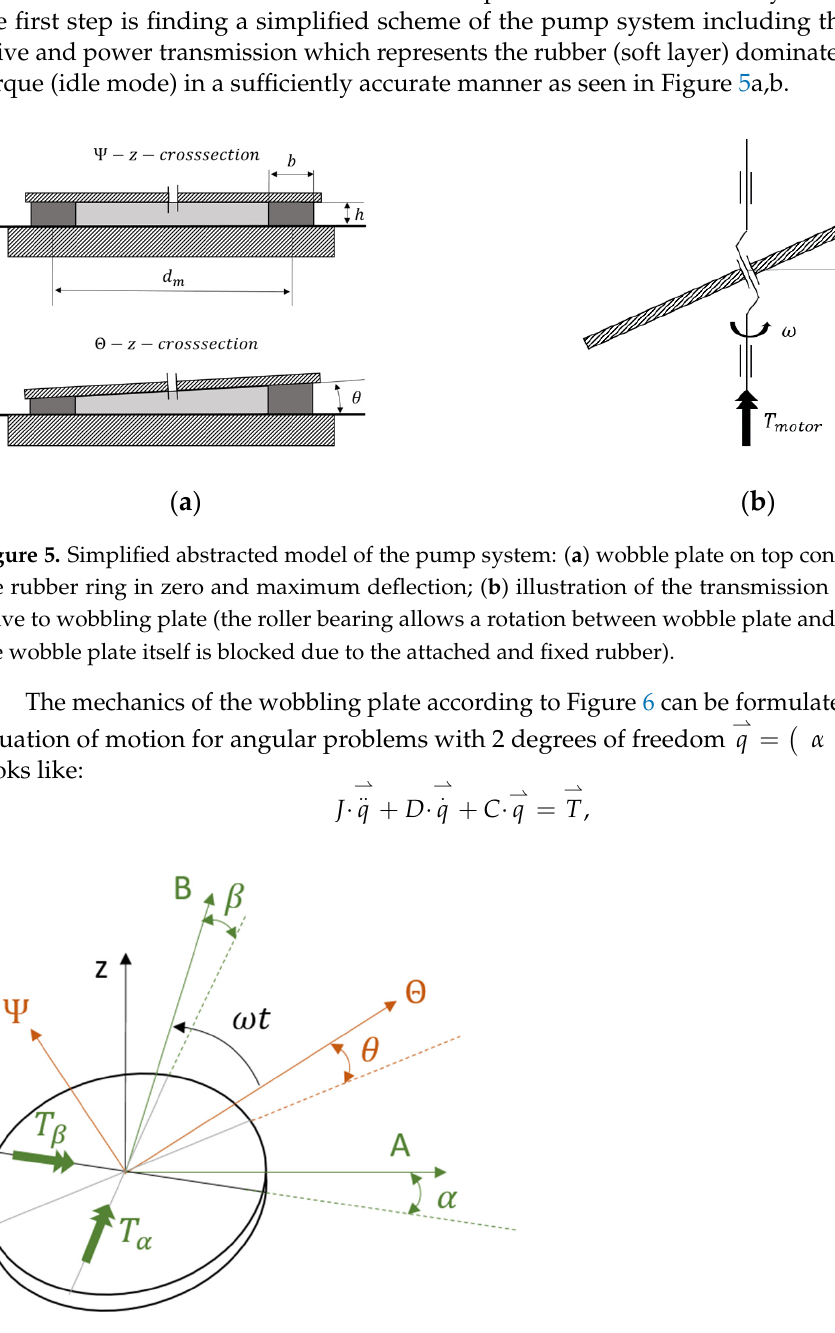
Figure 6. Wobbling plate with labelled kinematic parameters and torques.